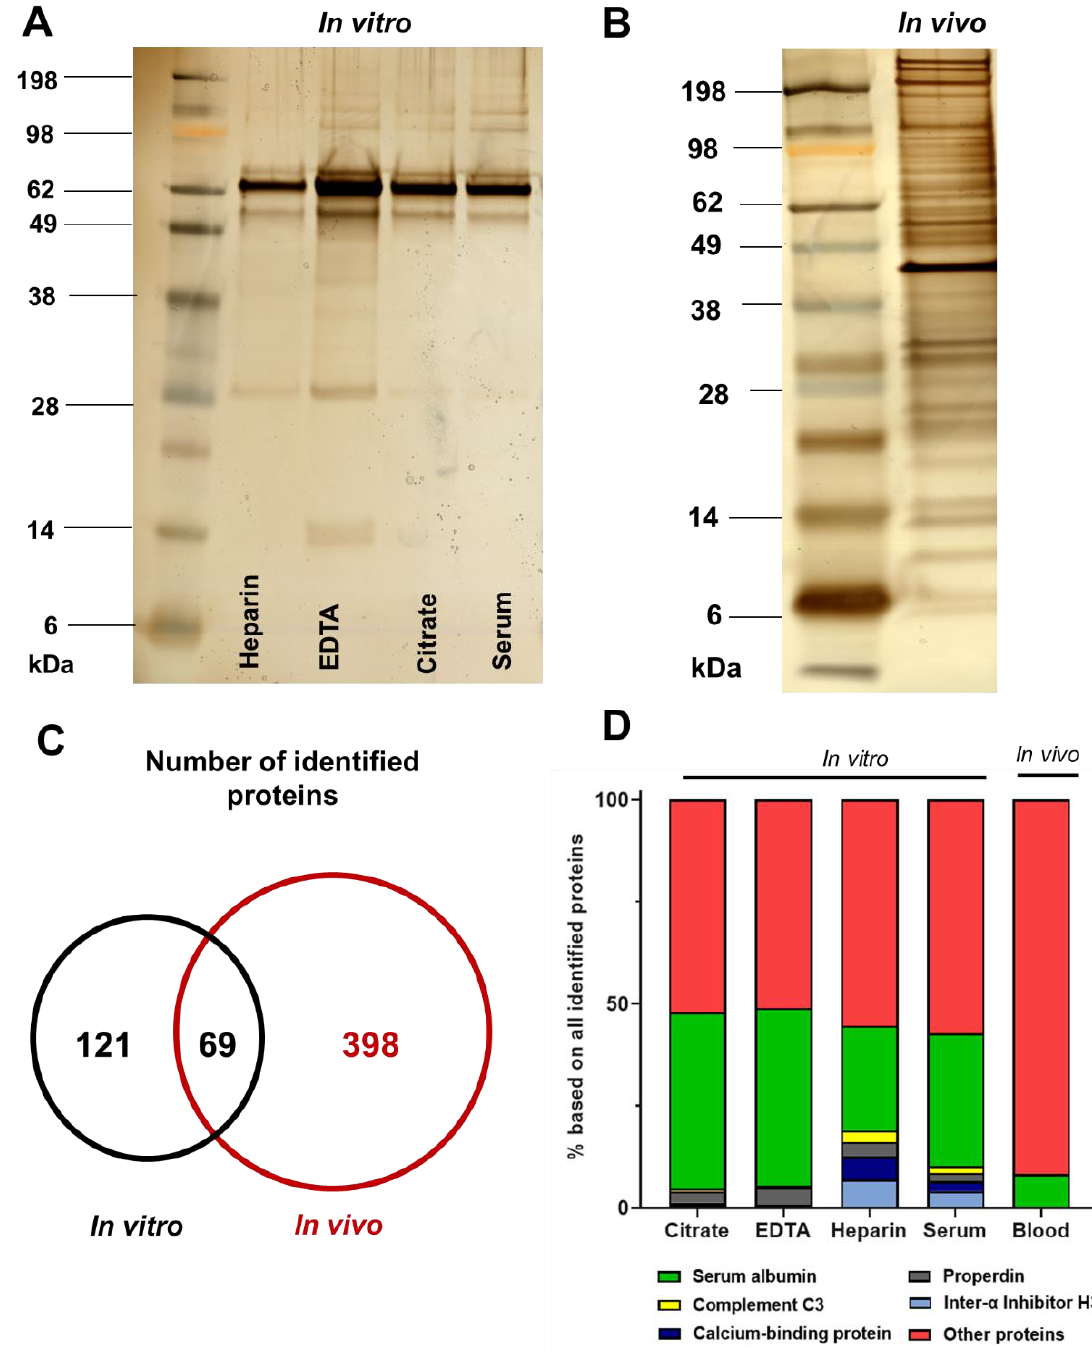
Figure 2. The in vivo corona pattern is not comparable with the in vitro situation. ( A ) mgHES nanoparticles were incubated with serum or plasma (heparin, EDTA or citrate) for in vitro protein corona analysis for 1 min. ( B ) Nanoparticles were recovered from the blood stream after 1 min of circulation and purified for protein corona analysis. As visualized by SDS PAGE ( A , B ) the pattern for the in vivo and in vitro situation highly differs. ( C ) LC-MS analysis indicates that the total number of proteins identified for the in vivo corona is significantly higher compared to the in vitro situation. Both corona types share a minor number of proteins. ( D ) The five most abundant proteins for the in vitro coronas after 1 min of incubation and their amount in the in vivo corona after 1 min of blood circulation. The average amount of each protein in % is shown and calculated from technical triplicates.